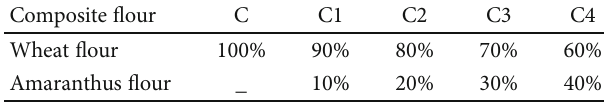
Table 1: Formulation of wheat and Amaranthus fl our. Composite fl our C C1 C4 Wheat fl